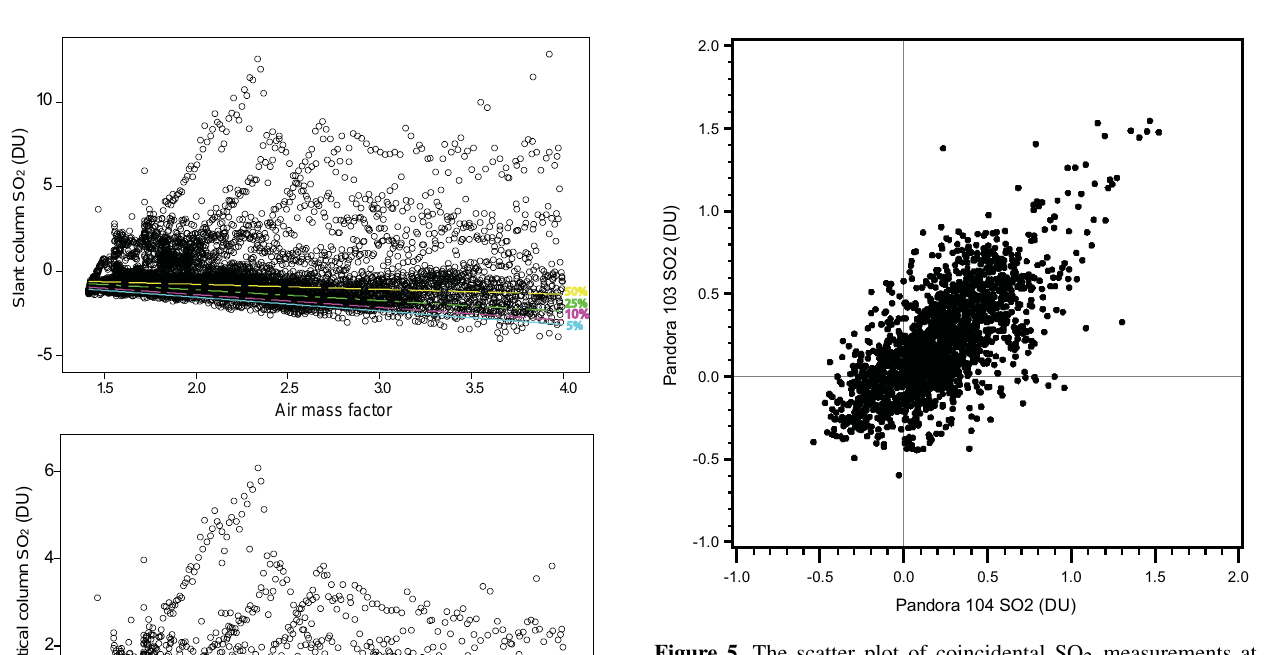
Figure 5. The scatter plot of coincidental SO 2 measurements at Downsview by Pandora 103 and 104 in January–July 2014. The data were grouped into 10min bins and only bins with between five and seven individual measurements were used for the comparison. The total number of bins was 1844. The correlation coefficient be- tween the plotted data is